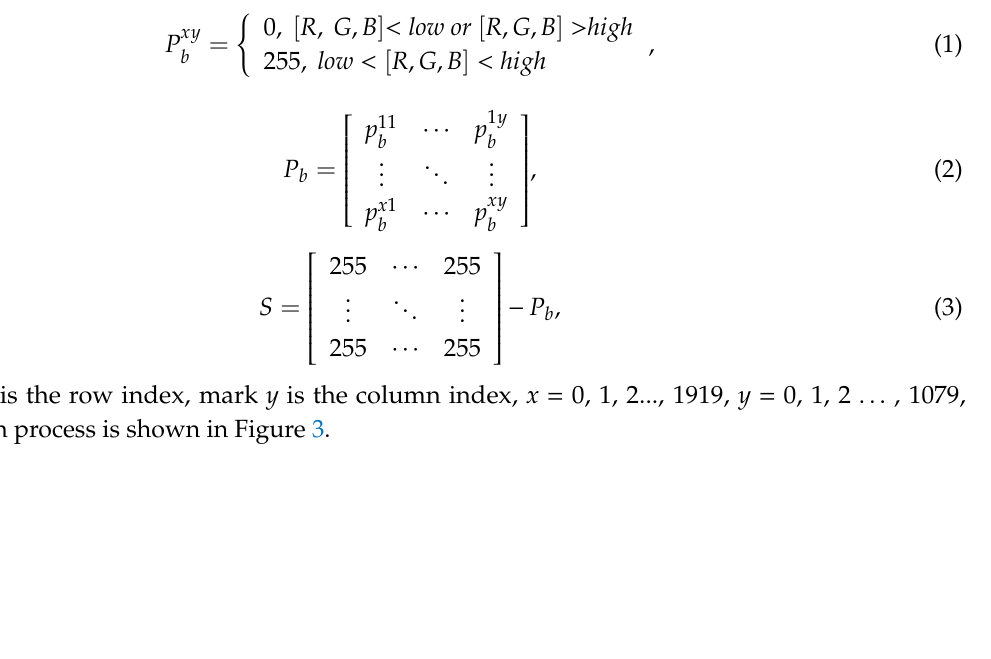
Figure 3. The extraction process of body part information of Bactrocera minax. ( a ) The original video